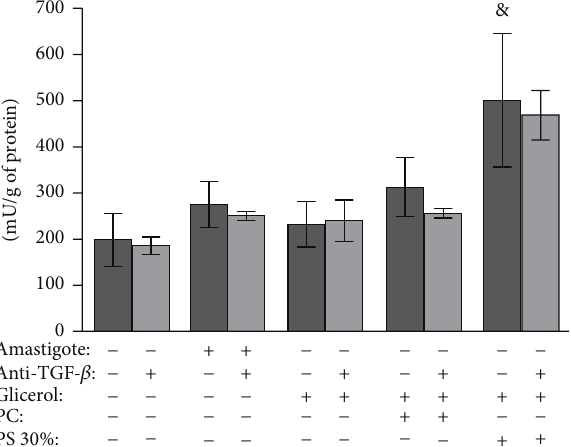
Figure 4: Effect of negatively charged lipid phosphatidylserine (PS)-liposomes on arginase activity of BALB/c macrophages. Peritoneal macrophages were infected with phosphatidylserine- (PS-) liposomes, phosphatidylcholine- (PC-) liposome or glycerol. Amastigotes of Leishmania (L.) amazonensis were used as controls. In parallel, an anti-TGF- 𝛽 antibody was used in all interaction conditions. Macrophages were lysed and the arginase activity was determined by measuring the urea level. Assays were run in triplicate. The data are presented as the mean ± standard deviation of enzyme activity units (amount of enzyme that catalyzes the formation of 1 𝜇 mol urea/min). The results are representative of two similar experiments. & 𝑃 < 0.05 compared with control without liposome (ANOVA and Student Newman-Keuls